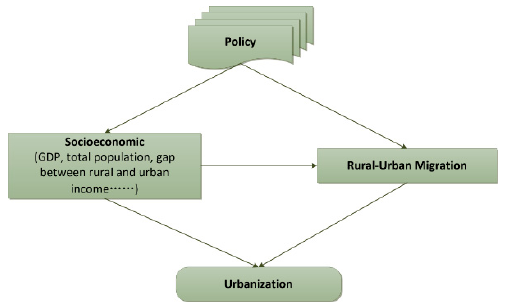
Figure 13. The linkage between policy, socioeconomic, rural–urban migration, and urbanization .